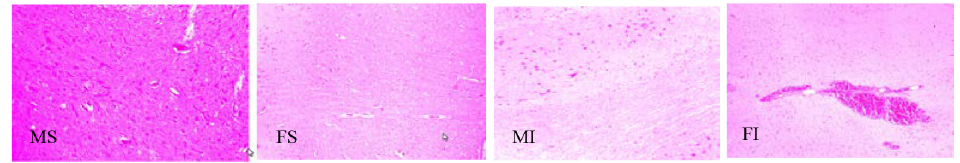
Figure 5. Comparison of Brain Tissue in Male Sham (MS), Female sham (FS) with Female Ischemia (FI) and Male Ischemia (MI) Groups. Congestion, gliosis, and necrosis are seen in the ischemia